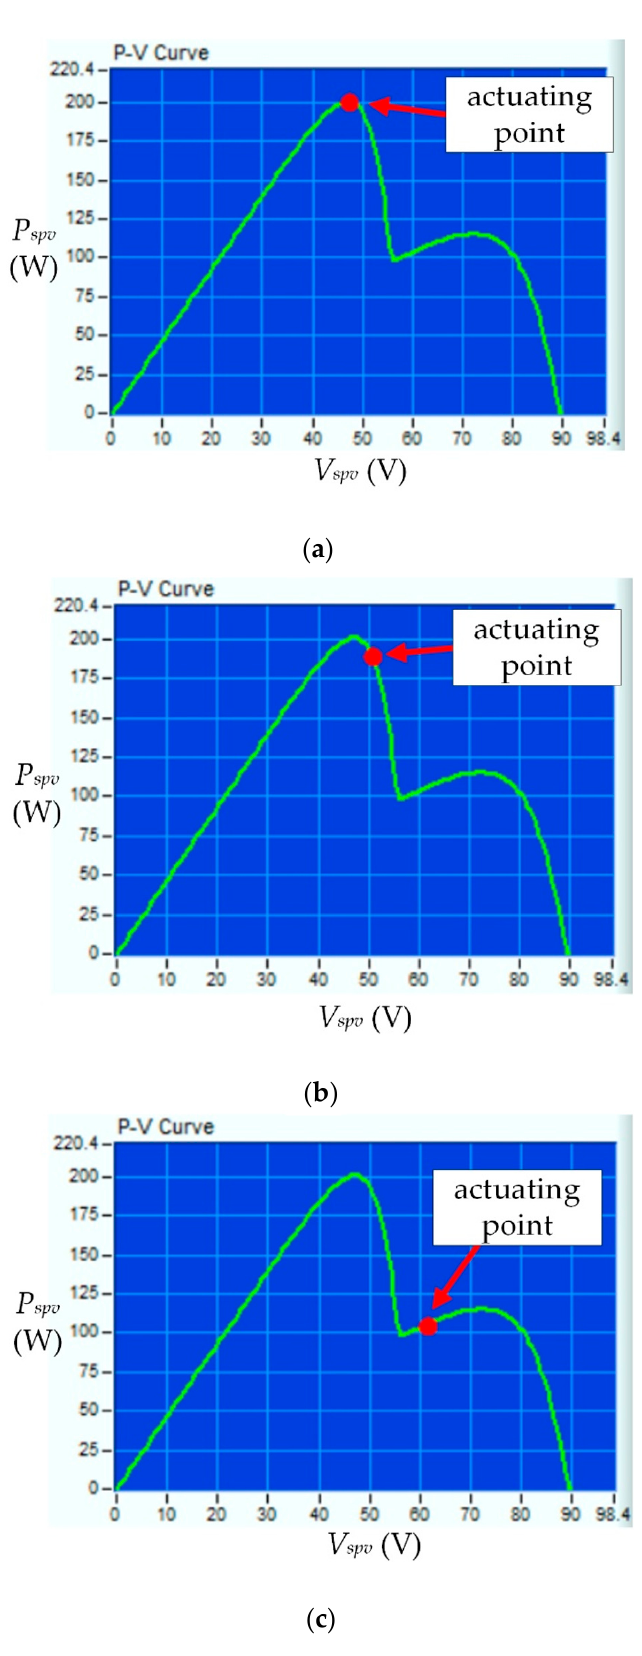
Figure 18. P spv − V spv characteristic curve of SPVM under PSC at IL = 700 W/m 2 and temperature = 25 °C by using the control strategy ( a ) SLOPDM, ( b ) SAH, and ( c ) P&O algorithms. Figure 19 demonstrate the P spv − V spv curve of the SPVM under PSC at IL = 65 W/m 2 and temperature = 25 °C. Figure 19a displays the experimental results of the proposed SLOPDM MPPT control strategy. First, uses the V spv , I spv , V o , and I o measurements. Second, angle θ 1 and MPPT duty cycle D were estimated using Equation (8) and Figure 9. The actuating point is accurately operated at MPP P mpp = 10.9 W like Figure 18a. Figure 19b,c are the results of the SAH and P&O algorithms, respectively. The SAH algorithm’s actu- ating point operated at P mpp = 10.3 W like Figure 18b. The P&O algorithm’s actuating point operated at P mpp = 3.9 W like Figure 18c.